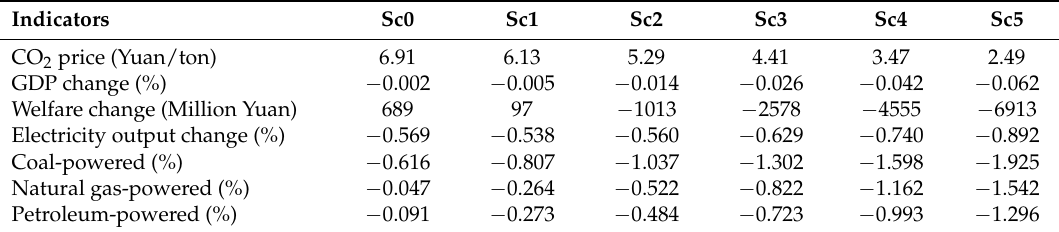
Table 11. Key results of sensitivity analysis (free quota